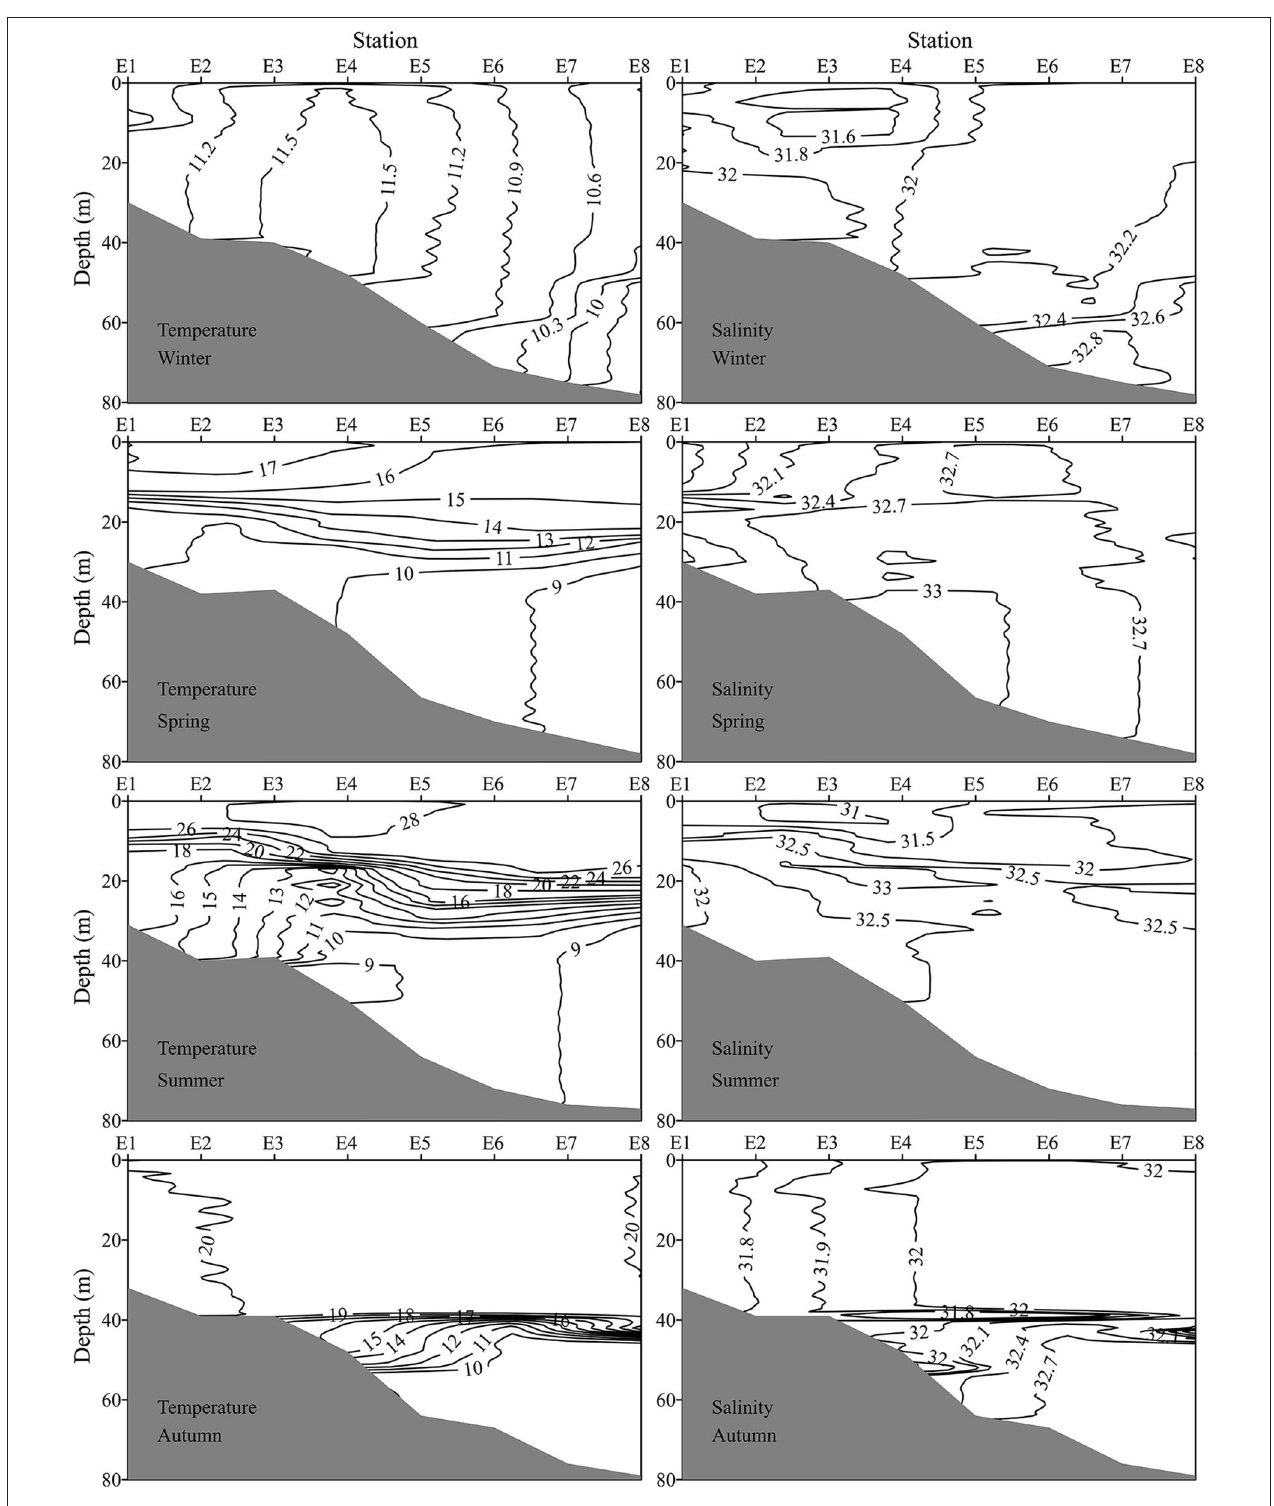
FIGURE 3 | Vertical profiles of temperature ( ◦ C) and salinity along transect E (indicated in Figure 1 ) during four seasons.